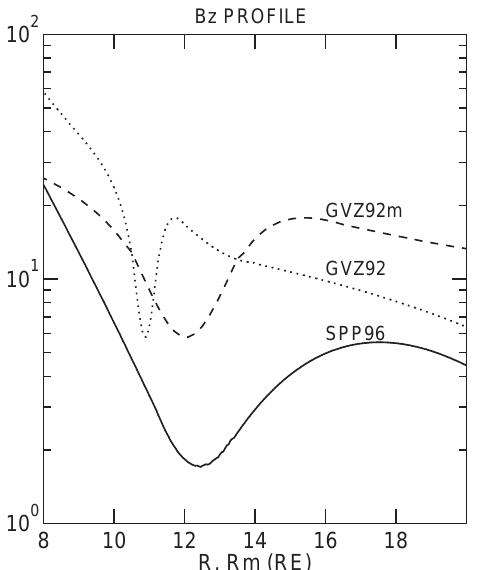
Fig. 7. Various radial B magnetic field profiles in the near-Earth (8– z 20 R ) neutral sheet used to model and map the field-aligned currents E down to the ionosphere: GVZ92 profile ( dotted line ): the hypothetical profile used in Galperin et al . (1992); SPP96 ( solid line ): the semi- empirical profile, from Sergeev et al . (1996); GVZ92m ( dashed line ): GVZ92 profile shifted and extended in tailward direction. (see Sect. 4.1.2